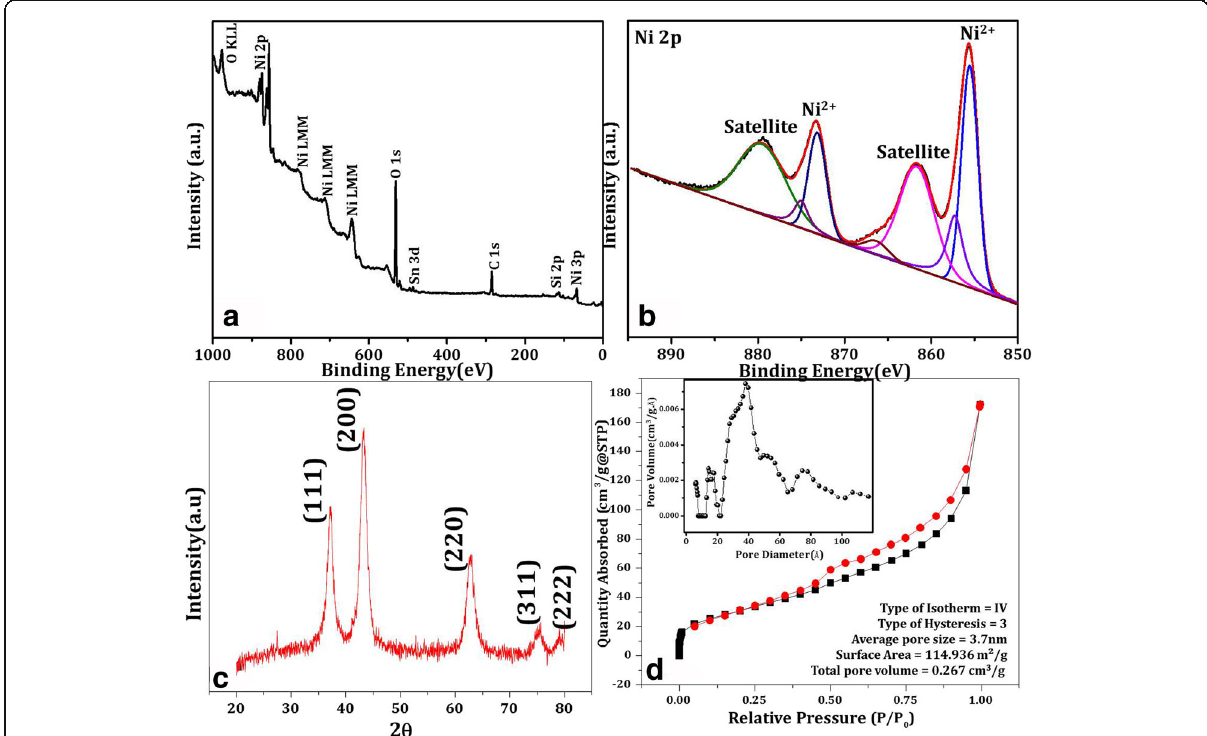
Fig. 2 Constituent analysis of the fabricated NiO nanopetals using XPS a survey scan, b deep scan of 2p Ni, c XRD for the structural analysis, and d surface area and textual study using BET isotherm measurement by N 2